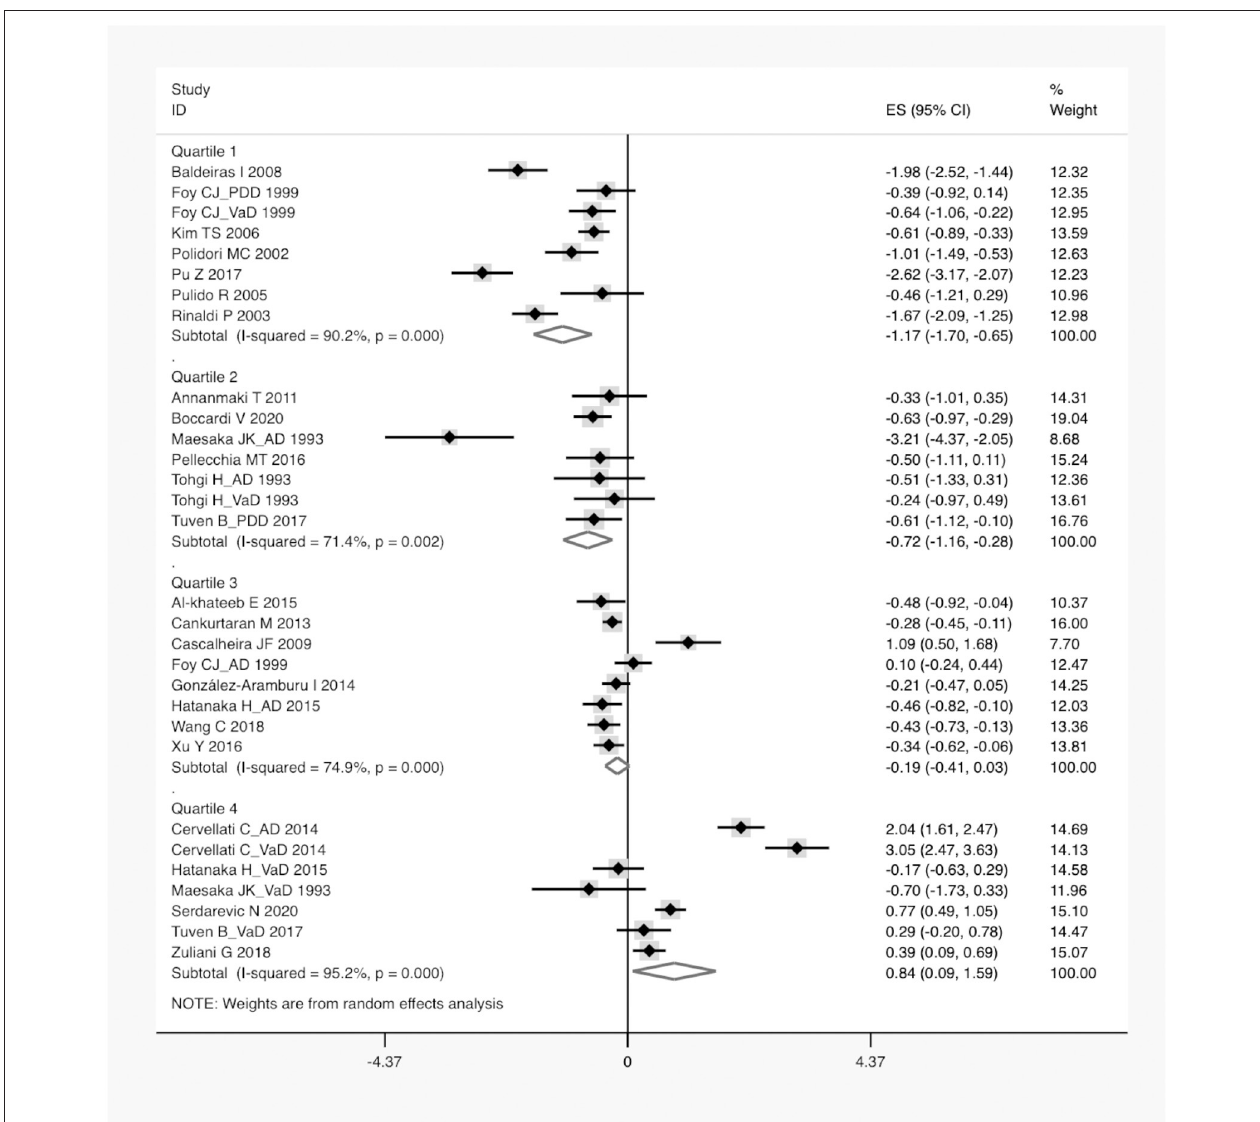
FIGURE 4 | A forest plot of the subgroup analysis on the concentration of serum UA between dementia and non-dementia. ES, effect size; CI, confidence interval; UA, uric